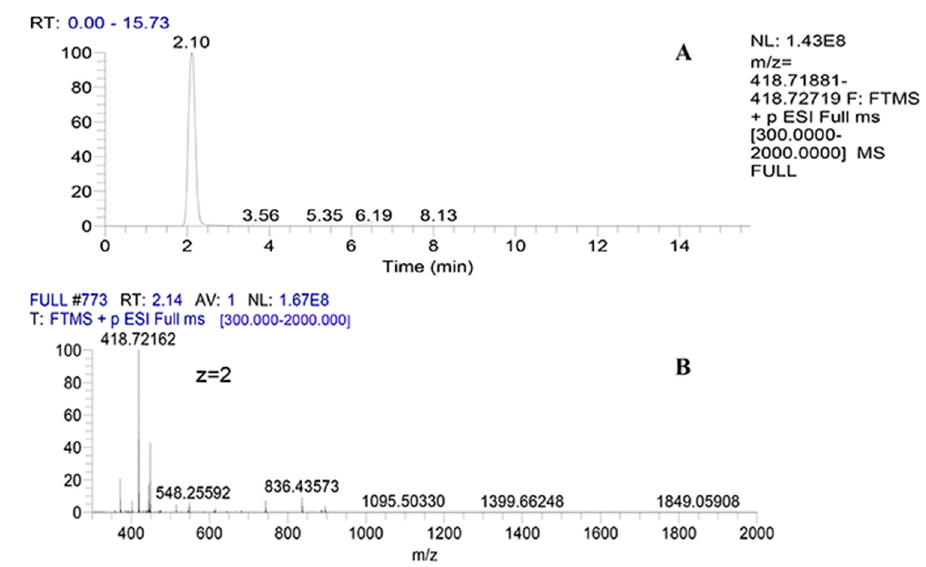
Figure 4. The extracted ion chromatogram ( A ) and MS spectrum ( B ) of m/z 418.723 detected in the digested bovine type I collagen reference material.